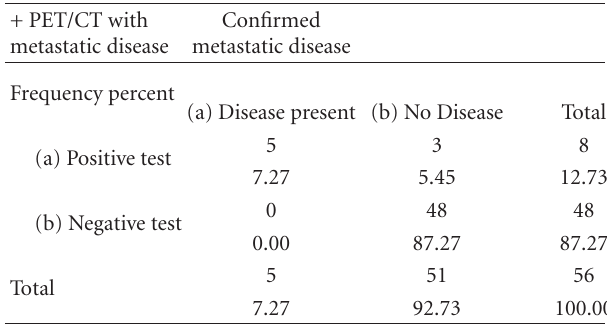
Table 5: 2 × 2 Table of PET/CT with distant metastatic disease. + PET/CT with metastatic disease